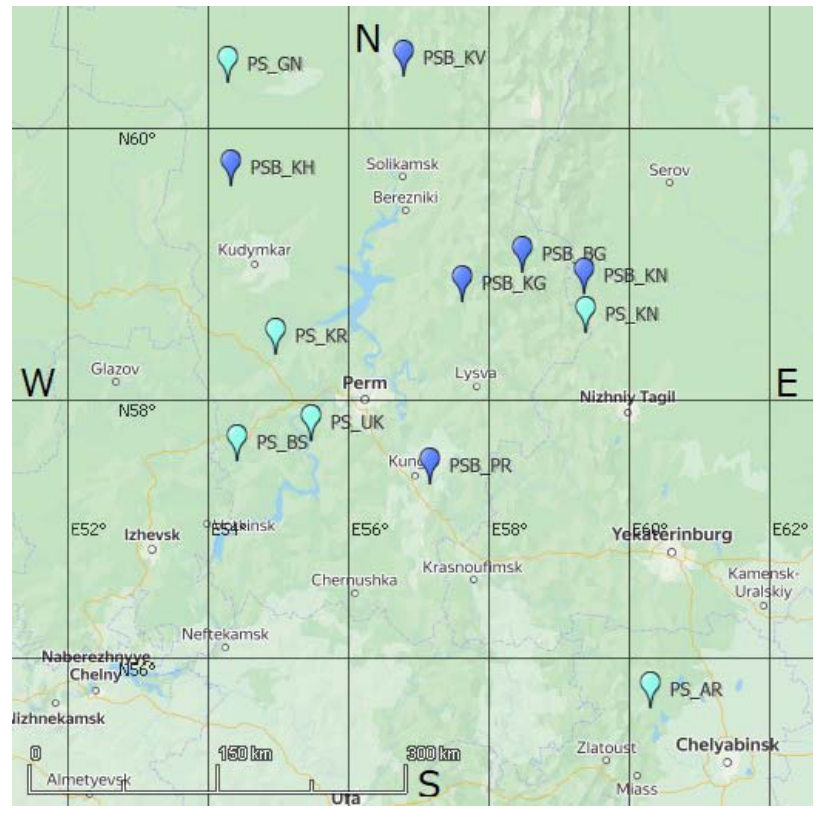
Figure 1. Schematic map of the location of the studied populations of P. sylvestris (cyan marker): PS_AR —Vishnyovogorsk; PS_KN —Verkhoturye; PS_GN —Gainy; PS_KG —Karagay; PS_UK —Perm; PS_BS —Bolshesosnovsky. P. sibirica (blue marker): PSB_KV —Krasnovishersk; PSB_KH —Kochyovo; PSB_KG —Chusovoy; PSB_BG —Gornozavodsk; PSB_KN —Verkhoturye; PSB_PR —Kishert.